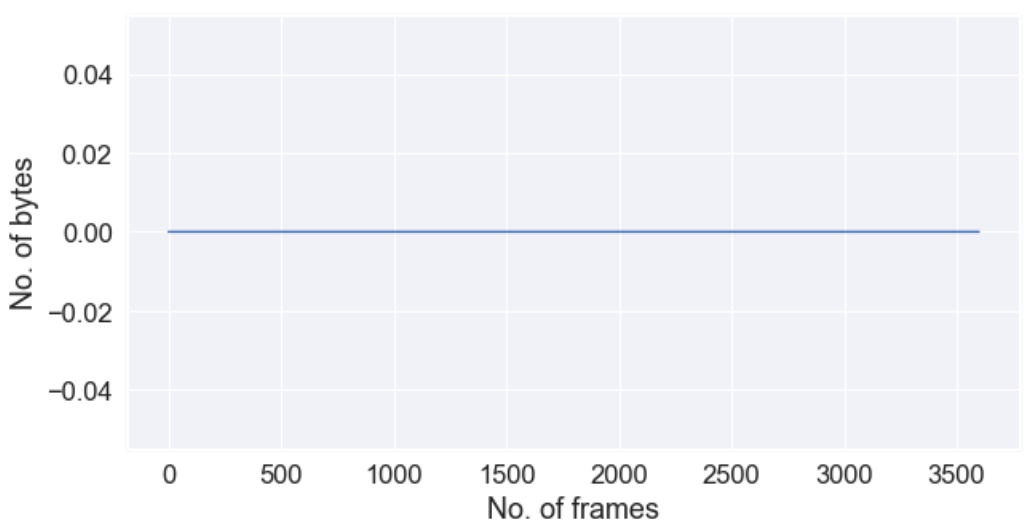
Figure 16a. I/O read requests